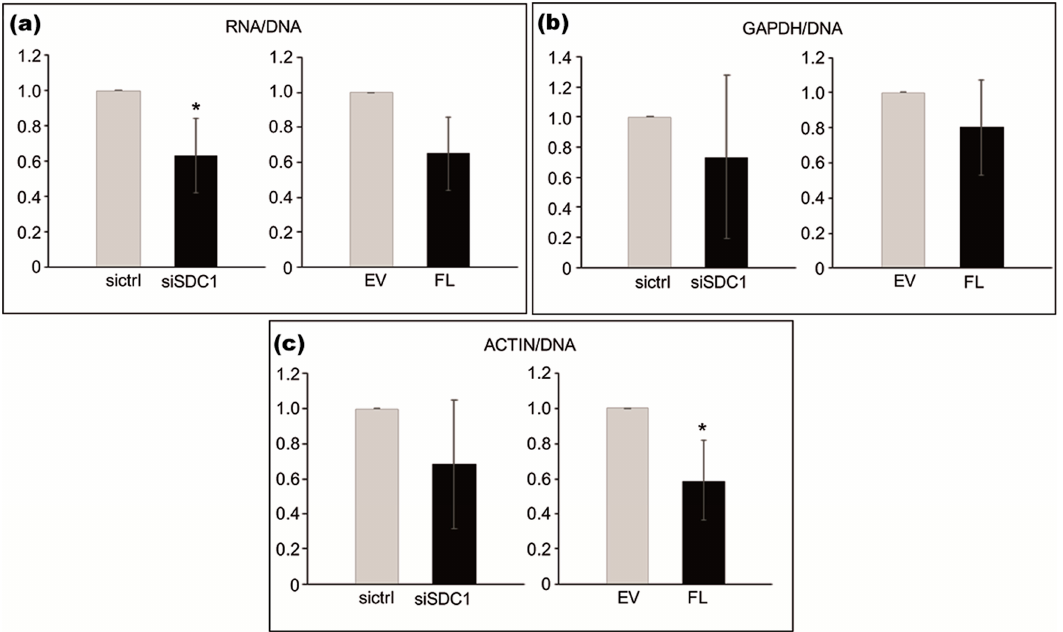
Figure 4. Effect of loss- and gain-of-SDC1 on cellular amounts of total RNA and specific RNA for actin, relative to DNA content. ( a – c ; left images) Bar graphs showing the effects of knocking down SDC1 by siRNA (siSDC1) versus control (sictrl) on total RNA ( a ), actin ( b ), and GAPDH ( c ) RNA levels. ( a – c ; right images) Bar graphs showing the effects of overexpressing full-length SDC1 (FL) versus an empty vector (EV) on total RNA ( a ) actin ( b ) and GAPDH ( c ) RNA levels. The results are based on three independent experiments. Asterisks indicate statistical significance from the corresponding controls (* p < 0.05).